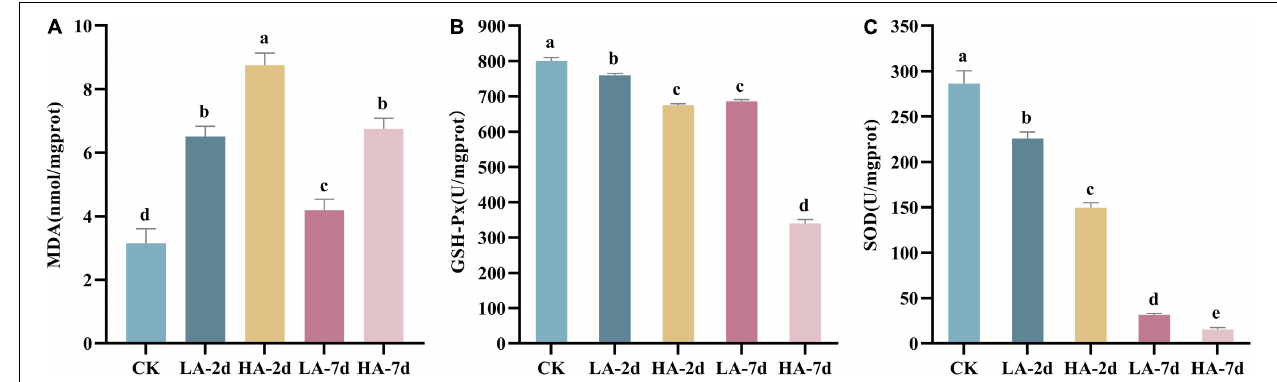
FIGURE 4 | Effect of AFB 1 on hepatic tissue lipid peroxidation level and antioxidant enzyme activities in rats. (A) Hepatic malondialdehyde (MDA) content, (B) hepatic glutathione peroxidase (GSH-Px) and (C) hepatic superoxide dismutase (SOD) activity.